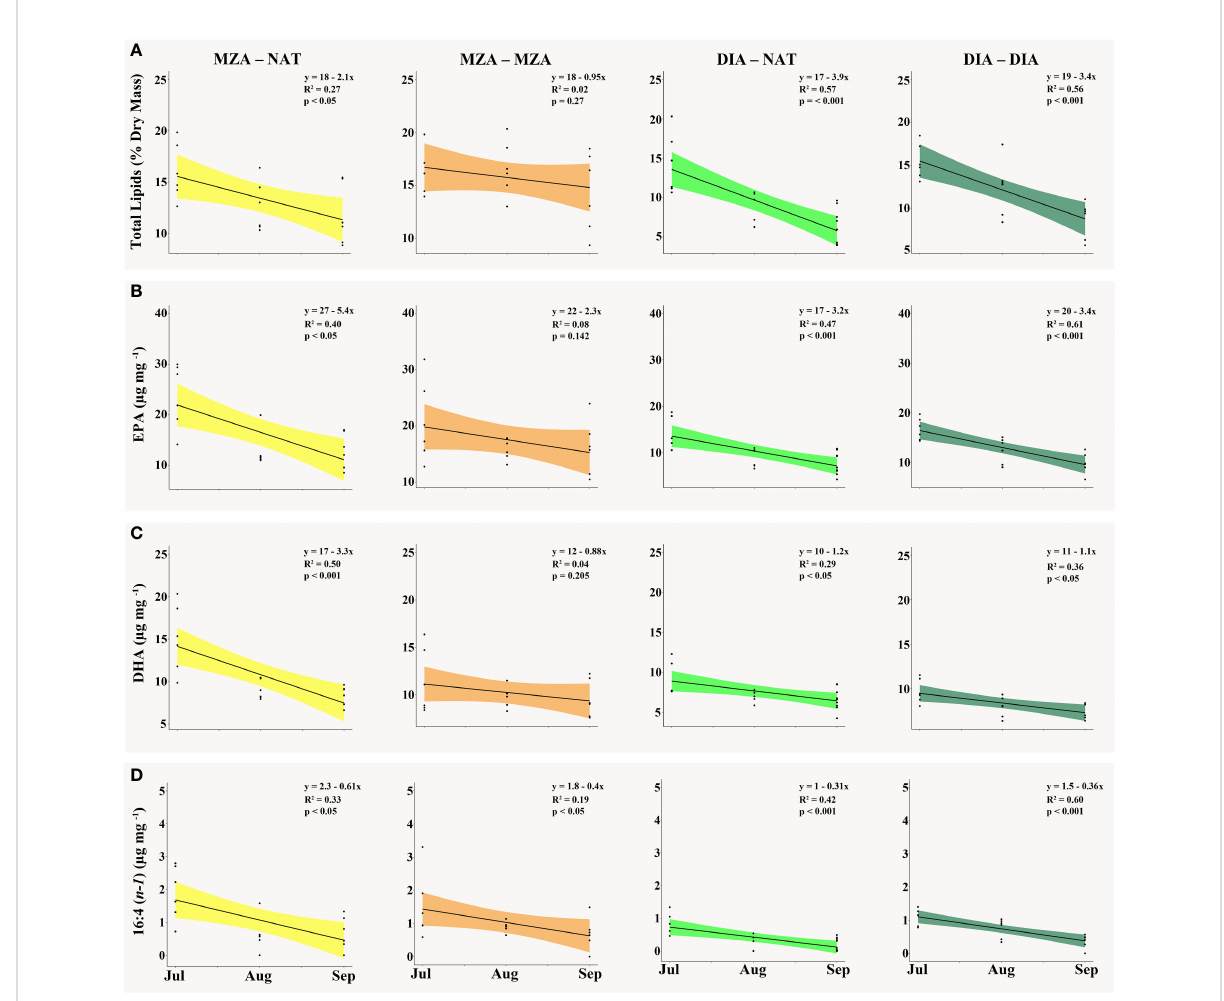
FIGURE 3 The (A) total lipid content as a percentage of krill dry mass (mg), (B) EPA [20:5( n-3) ] content (µg mg -1 ), (C) DHA [22:6( n-3) ] content (µg mg -1 ) and (D) 16:4( n-1) content (µg mg -1 ) present in krill tissue in the MZA - NAT (yellow), MZA - MZA (orange), DIA - NAT (light green) and DIA - DIA (dark green) food environment scenarios (FES) from July to September. Abbreviations: MZA - MZA, mixed zooplankton assemblage from May to September; DIA - DIA, diatoms from May to September; MZA - NAT, natural seawater, fed MZA from May to July, and DIA - NAT, natural seawater, fed DIA from May to